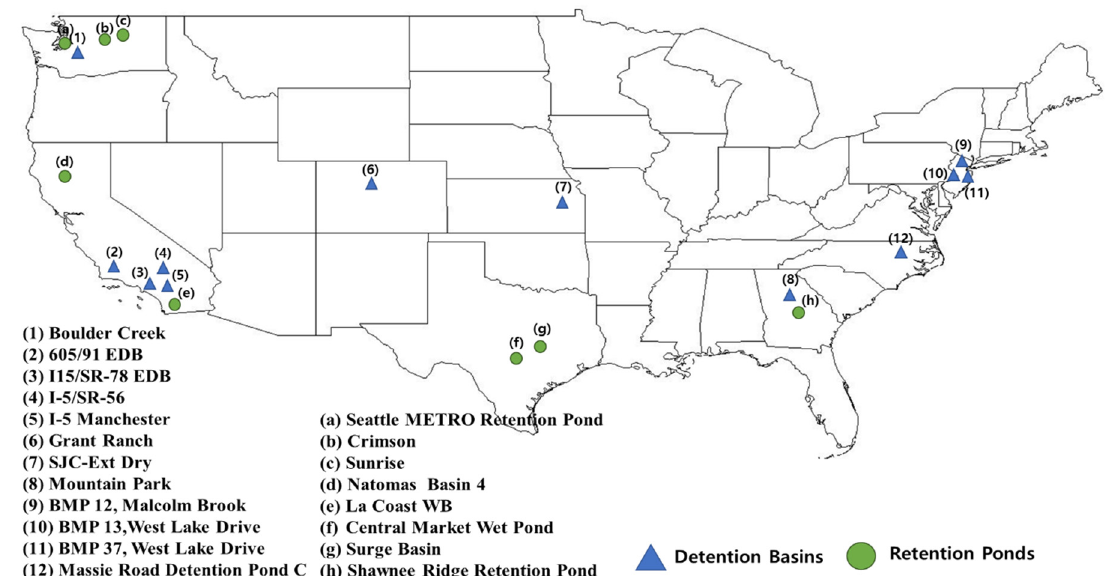
Figure 1. Locations of the detention basins and retention ponds used in this study.